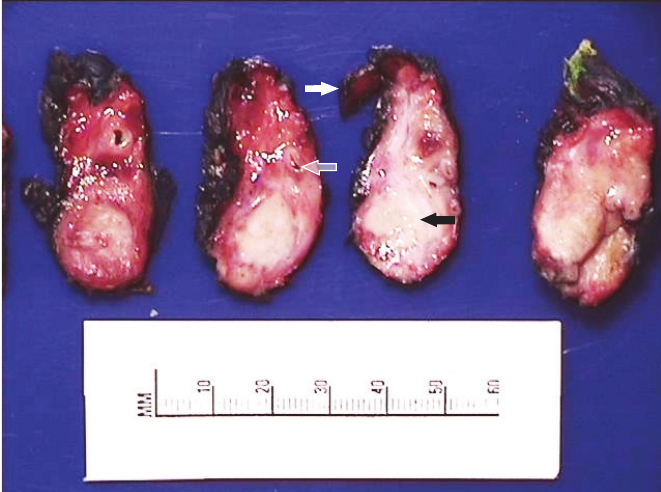
Figure 4: Cross sections of gross pathologic specimen. Black arrow points to fibrosis within the body of the resected pancreas. White arrow points to resected adrenal gland. Translucent arrow denotes the splenic artery encased in fibrosis.